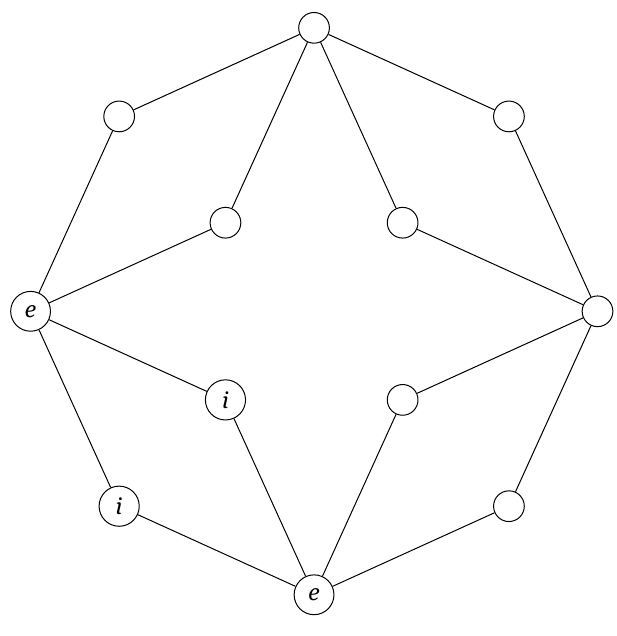
Fig. 1. Diamond D 2 with a subdiamond of height 2 labelled with letters. The exits of the subdiamond are labelled with e , other vertices of the subdiamond are labelled with i .